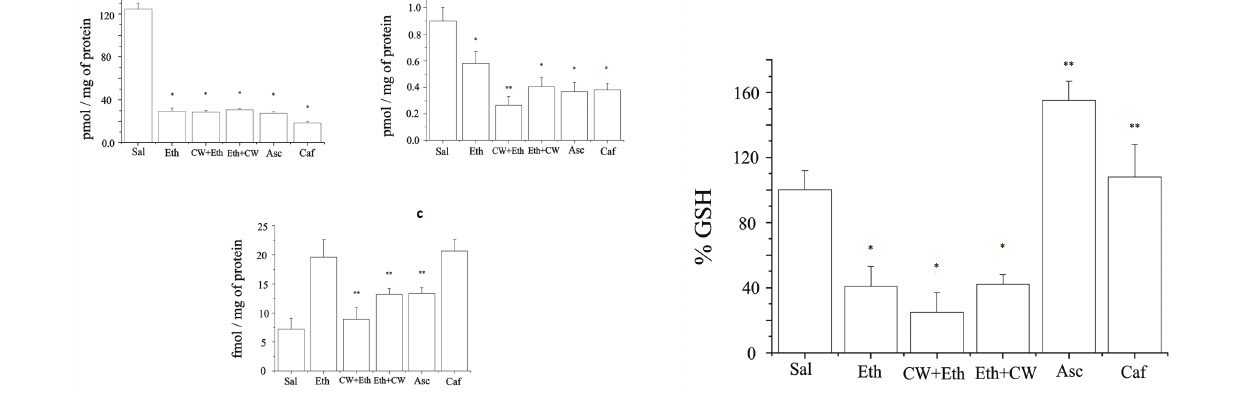
Figure 5 - Effect of CW, ascorbic and caffeic acid of GSH and GSSG levels in liver of rats treated by ethanol. A – GSH concentration, B - GSSG concentration, C – GSSG/GSH ratio. Eth – 2.5 mL/Kg of solution 35%; CW+Eth –3 mL/Kg of coconut water followed by ethanol 2.5 ml/Kg; Eth+CW – ethanol 2.5 mL/Kg followed by coconut water 3 mL/Kg; Asc + Eth – 3 mL of solution 25 µg/µL followed by ethanol 2.5 mL/Kg; Caf + Eth – 3 mL of solution 100 µg/µL following by ethanol 2.5 mL/Kg. The data are average ± S.D for five animals. Means values were significant different for p<0.05; (*) different when compared with saline group p<0.05; (**) different when compared with ethanol group p<0.05. For multiple comparisons, ANOVA, followed by Dunnett’s test, were applied.